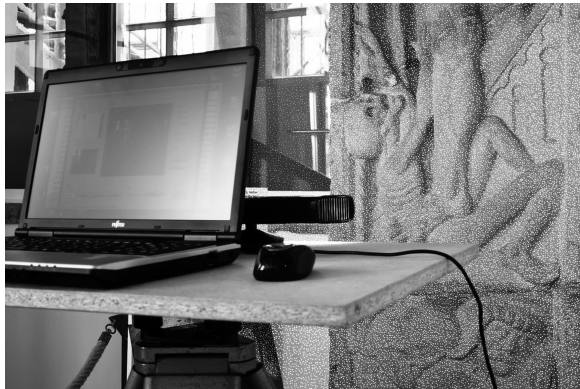
Figure 3: Infrared photo showing the point pattern and the Kinect on site in operation